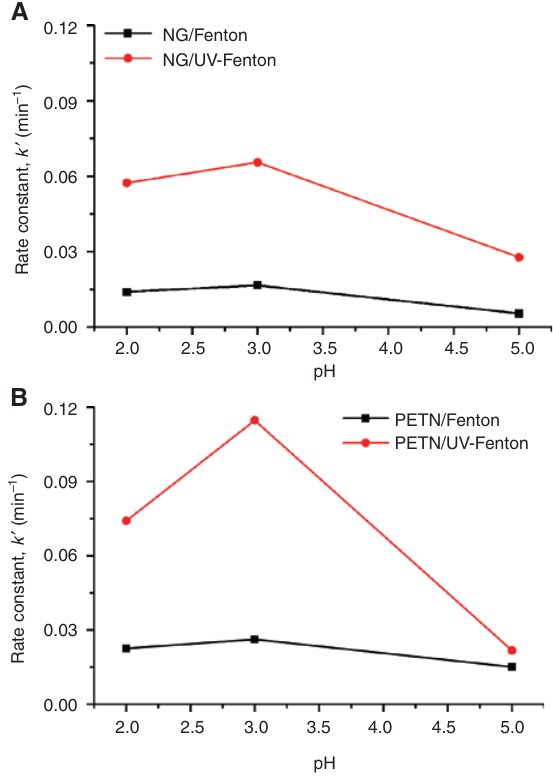
Table 2: Influence of H and PETN in different AOPs.